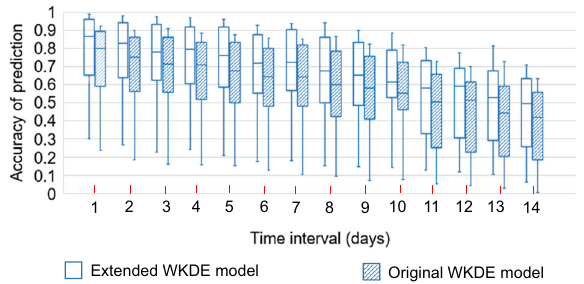
Fig. 1 Accuracy of the predicted risk of COVID-19 symptom onset by the extended and original Weight Kernel Density Estimation (WKDE) models, under the scenario of Wuhan lockdown. The predicted onset risk is a standardised value between 0 and 1, indicating risk relative to the highest predicted risk among all locations on the date for which the risk of symptom onset is predicted, hereafter termed “ the prediction date ” (see Methods section for further detail). The prediction accuracy is de fi ned as the percentage of the con fi rmed cases in the areas in which the predicted onset risk was >0.8 22 on the prediction date. The time interval denotes the period between the base date and the date of prediction. The horizontal line in the box denotes the median, while the lower and upper edges of the box represent the respective fi rst and third quartiles. The lines emanating from the box upwards and downwards represent the respective maximum and minimum values.